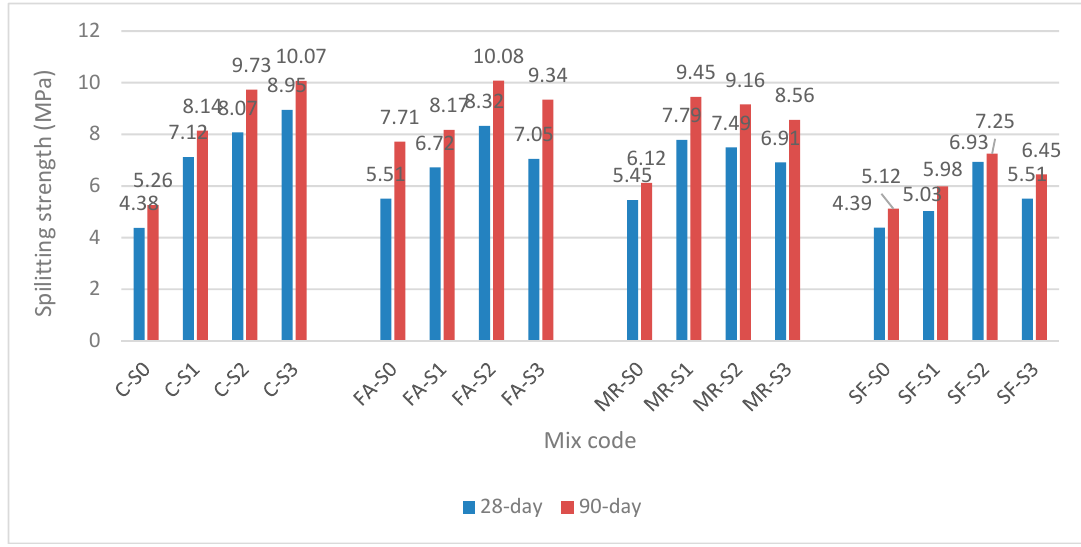
Figure 5. Compressive strength test at 7, 28, and 90 days.